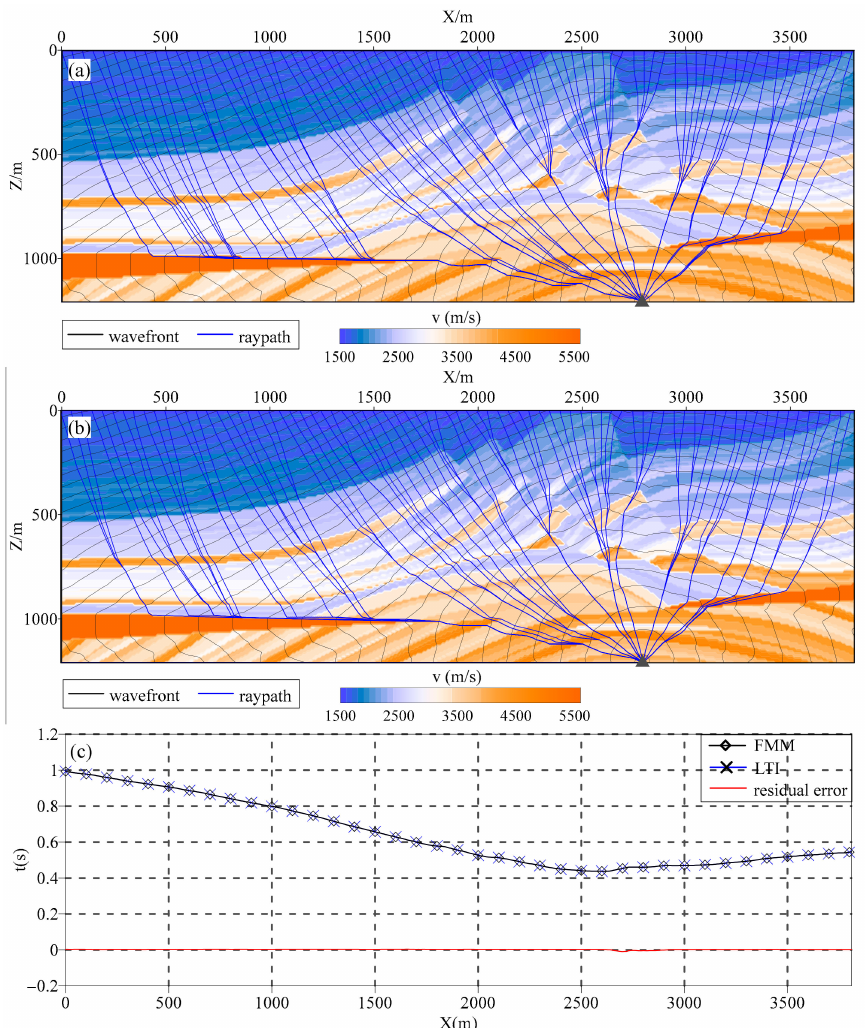
Figure 8. Comparison of wavefront and raypath between ( a ) FMM and ( b ) LTI. ( c ) Comparison of traveltime between FMM and LTI. The refined grids around the source are 100 grid layers and 4 points of each grid in FMM. The LTI results are from [36]. The gray triangle (cid:78) represents the